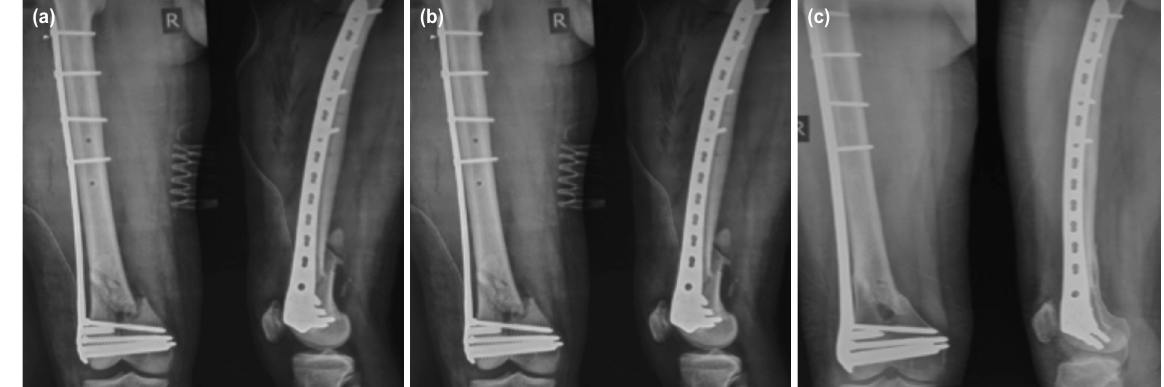
(a) Pre-operative radiograph (b) Immediate post-operative radiograph, (c) six months post-operative radiograph. Fig. 2: